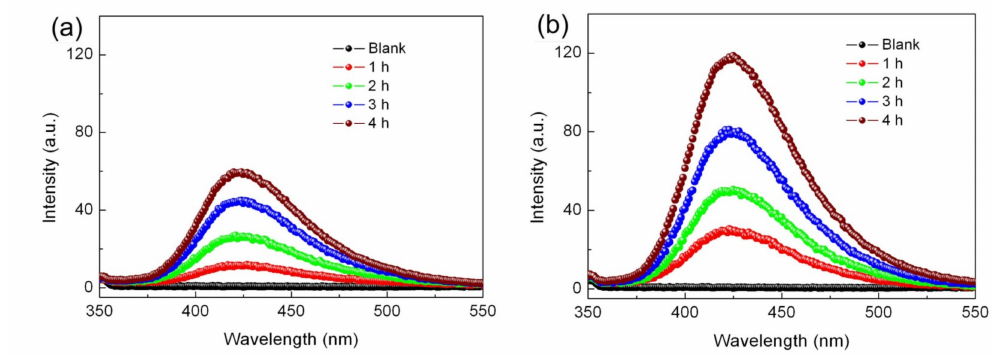
Figure 11. Time-dependent PL spectra of the terephthalic acid (TA) solution after ( a ) photocatalytic and ( b ) photo-Fenton reactions over 15% Ag 2 S/BiFeO 3